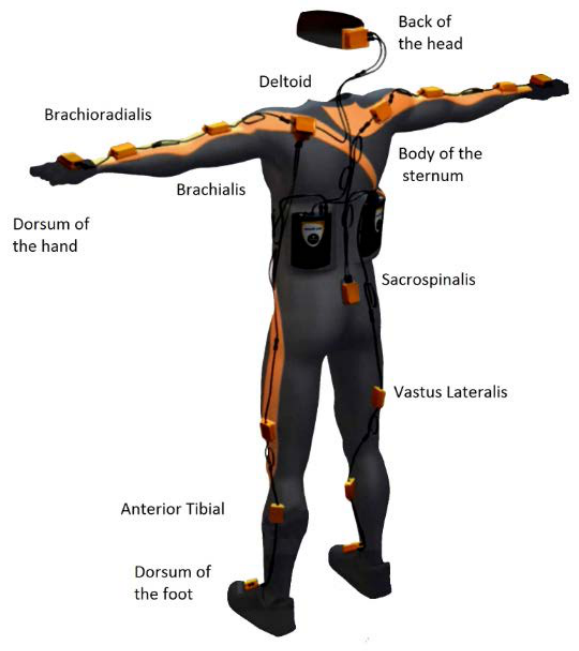
Figure 3. Positioning of inertial sensor